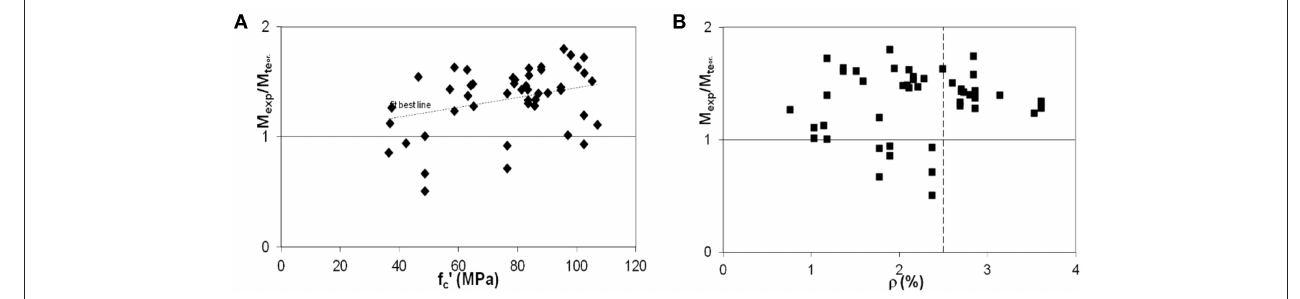
FIGURE 6 | Variation of the ratio between experimental and analytical moment with: (A) concrete compressive strength; (B) steel reinforcement percentage.